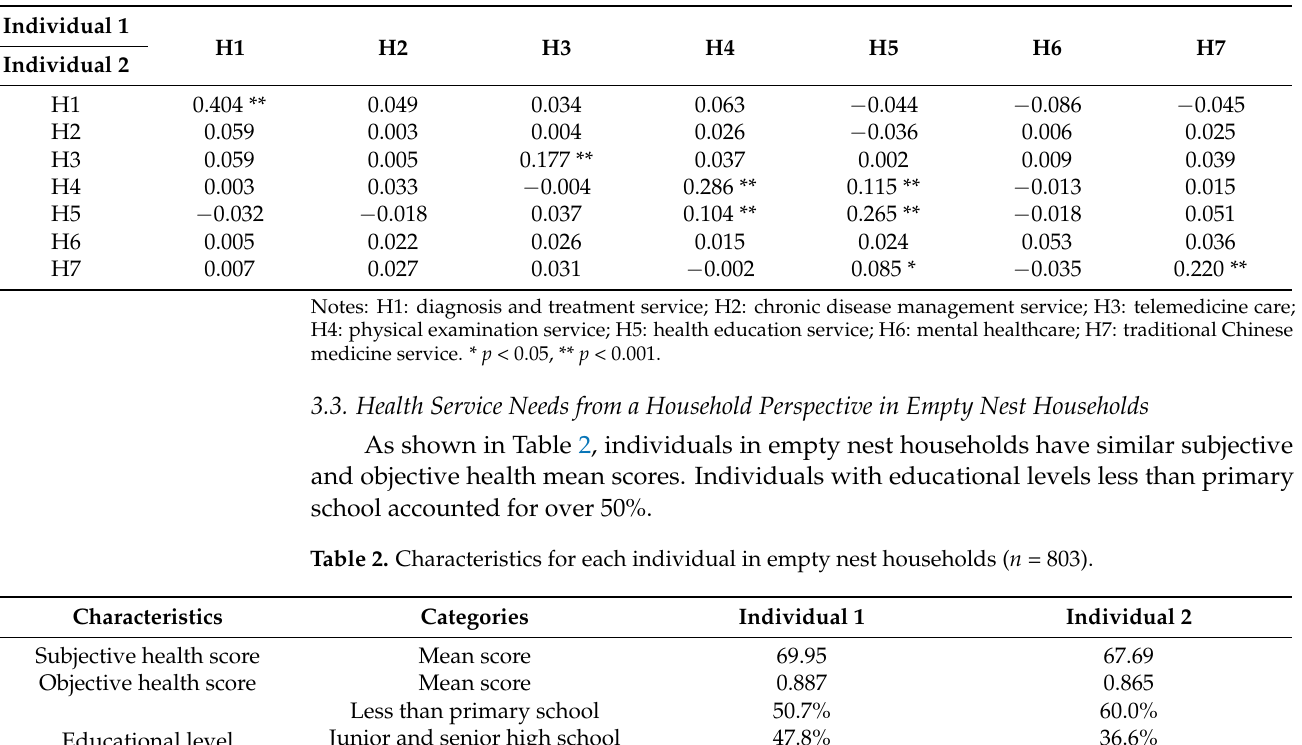
Table 1. Correlations between individuals’ health service needs ( r ).